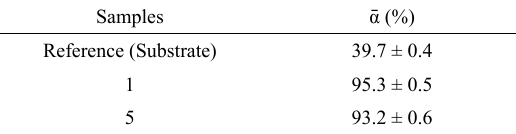
Table 5. Chemical compositon of the sample 5 in differents points.